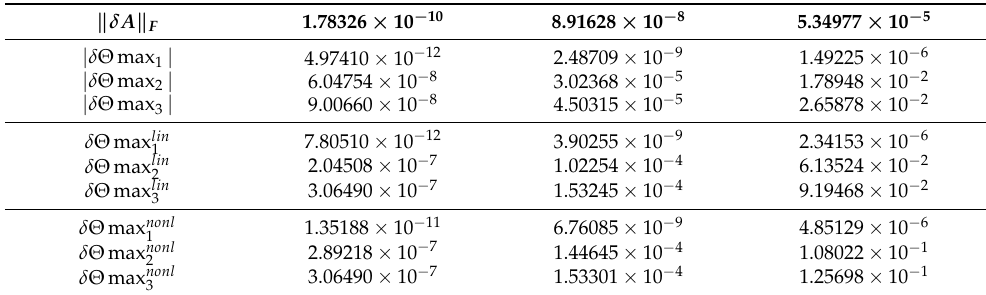
Table 4. Exact perturbations of the maximum subspace angles and their linear and nonlinear